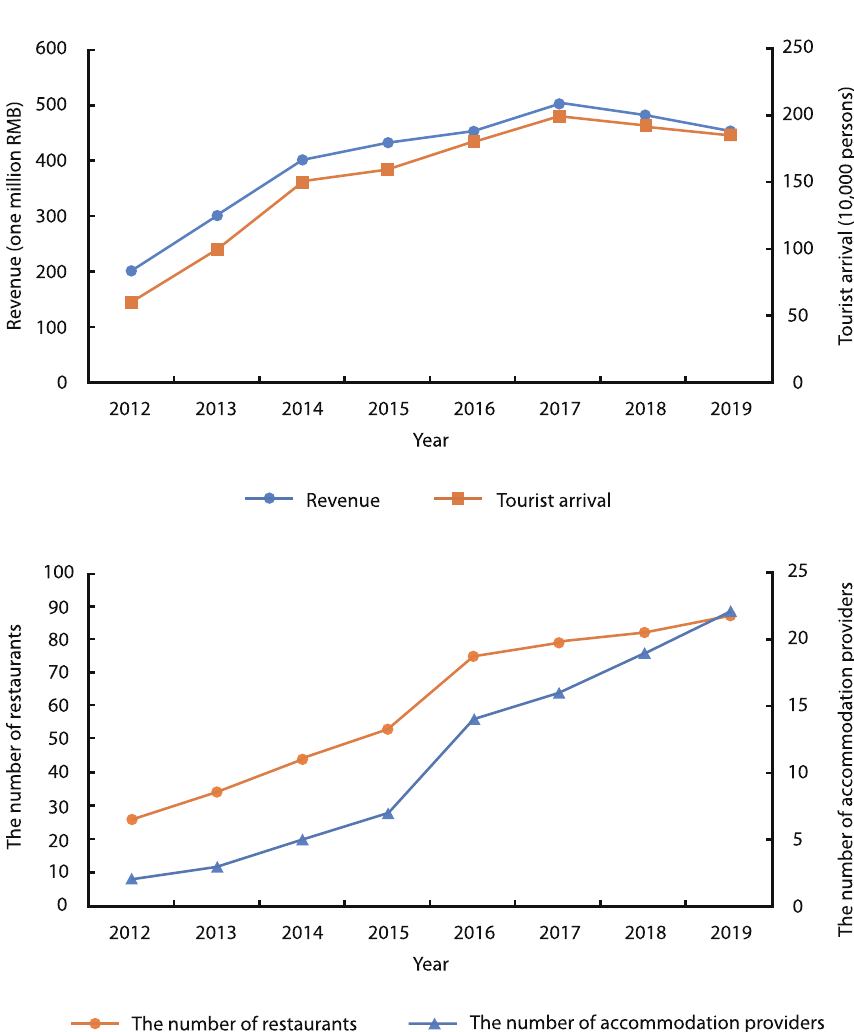
Fig. 4 Increased tourist arrivals and revenue (top) and businesses (bottom) in Guangfu Ancient City (Source: the authors)